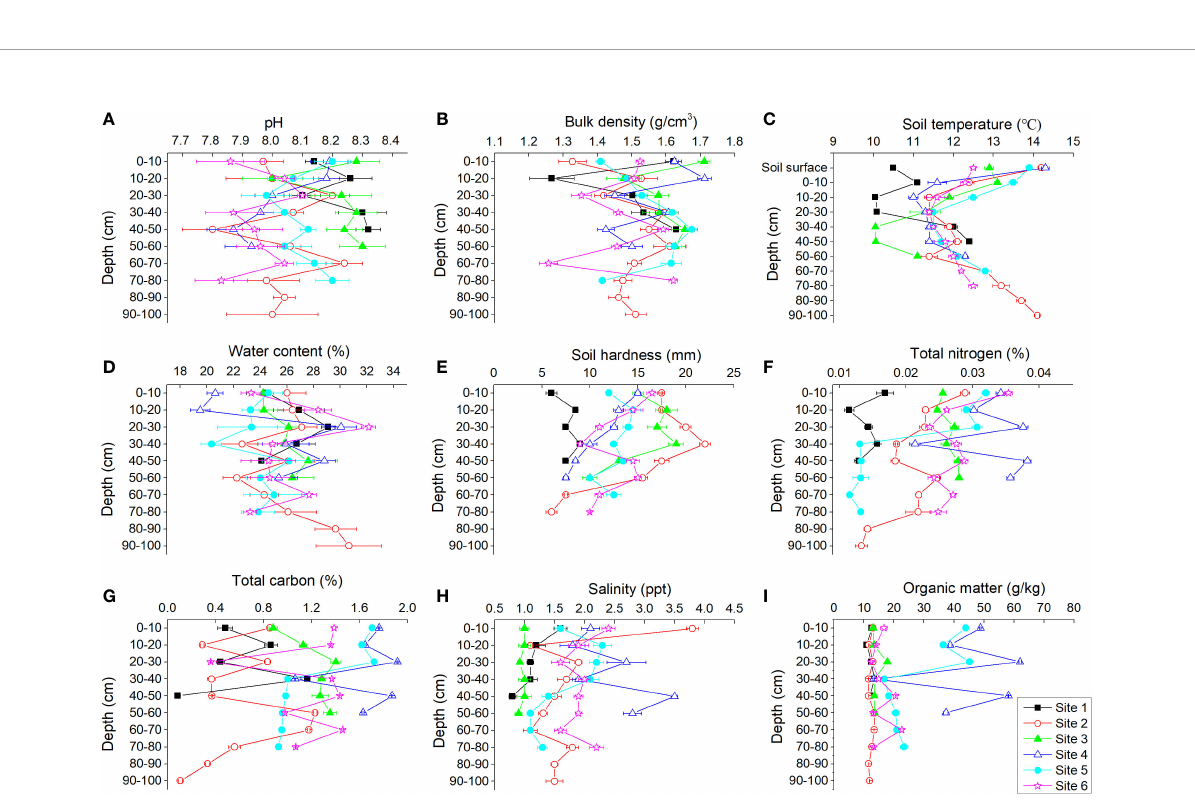
FIGURE 5 Pro fi le distributions of pH (A) , bulk density (B) , soil temperature (C) , water content (D) , soil hardness (E) , total nitrogen (F) , total carbon (G) , salinity (H) , and organic matter (I) at each site of the Yellow River